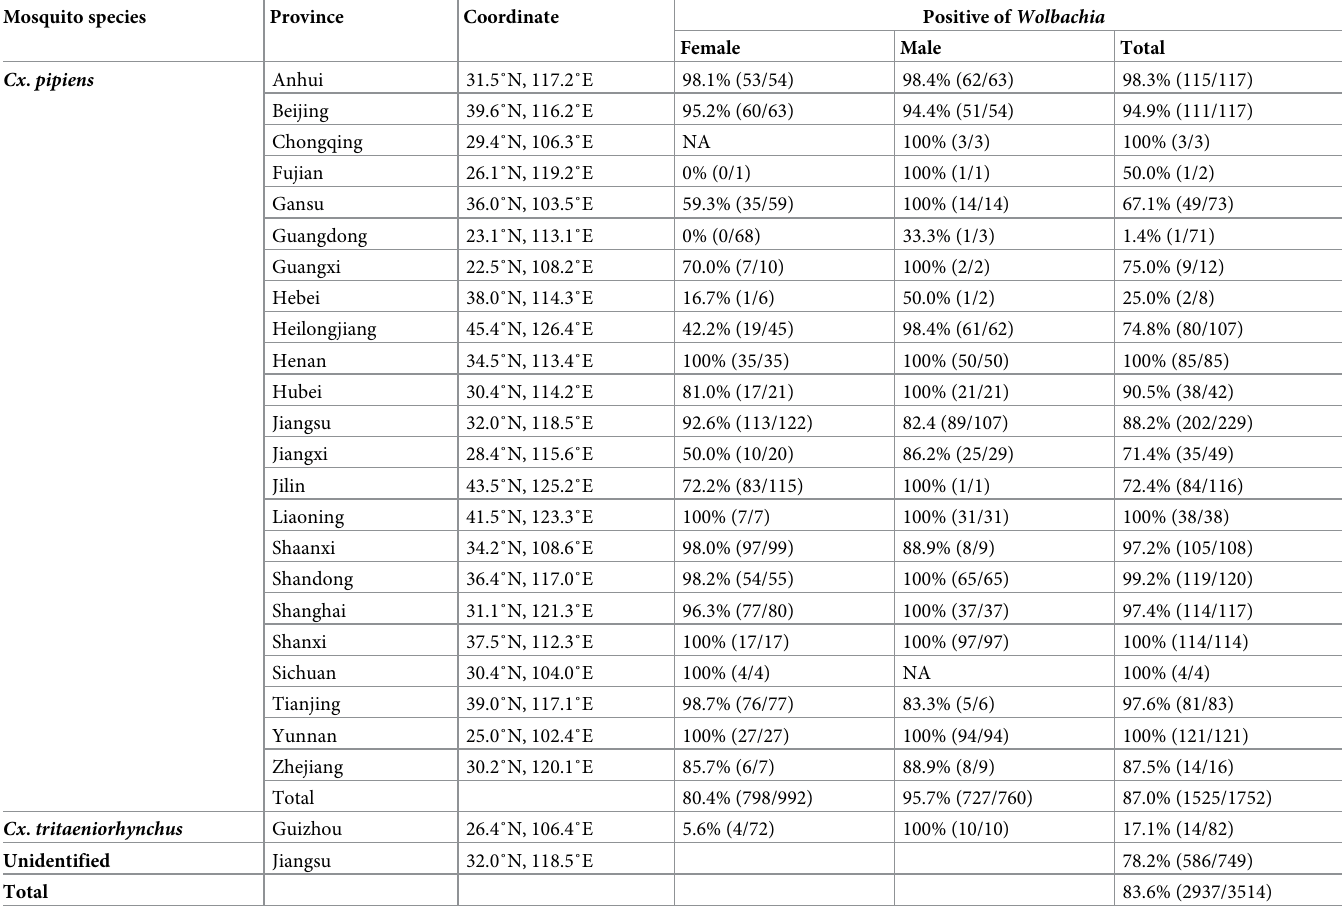
Wolbachia was available to be detected in four species of mosquitoes, including Ae . albopictus , Ar . subalbatus , Cx pipiens and Cx . tritaeniorhynchus . Only the positive samples of Ae . albopic- tus shared both supergroups, while the Wolbachia in Ar . subalbatus (supergroup A), Cx . pipiens (supergroup B) and Cx . tritaeniorhynchus (supergroup B) belonged to a single super- group, respectively. In supergroup A, the partial sequences of wsp gene amplified from 26 Ar . subalbatus (14 females and 12 males) were identical to KJ140131 identified in Ae . albopictus in China. The remaining three strains (MW718054, MW718057 and MW718097) in supergroup A were closest to KJ140127 ( Ae . albopictus , China). In supergroup B, the Wolbachia wsp sequences identified in this study were clustered into two sub-clades. The first sub-clade con- sisted the 81.5% (22/27) of Wolbachia sequences amplified from Ae . albopictus in this study. The second sub-clade consisted of all the Wolbachia wsp sequences obtained from Cx . pipiens (n = 52) and Cx . tritaeniorhynchus (n = 4), and two sequences obtained from Ae . albopictus (Fig